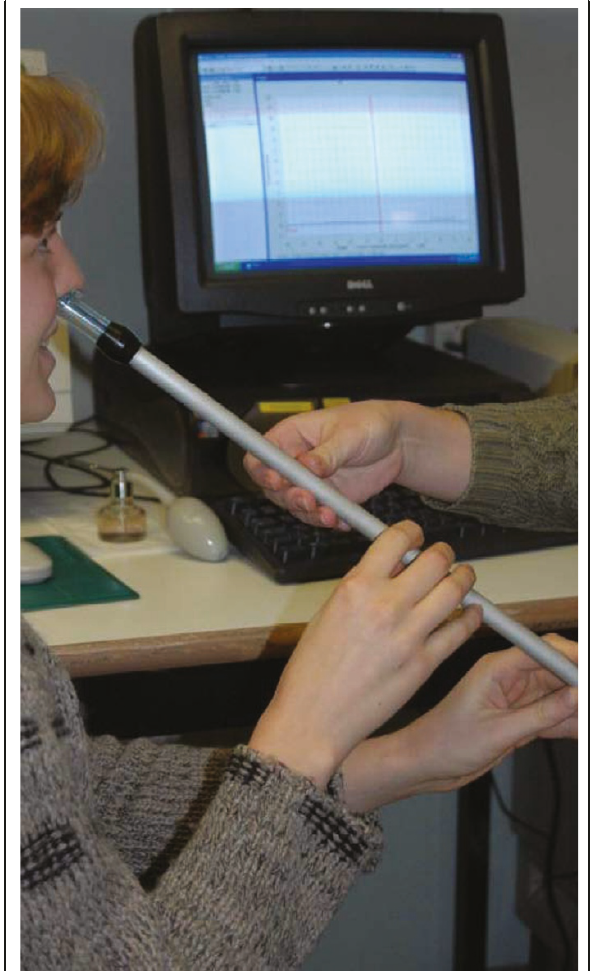
Figure 14 Acoustic rhinometry